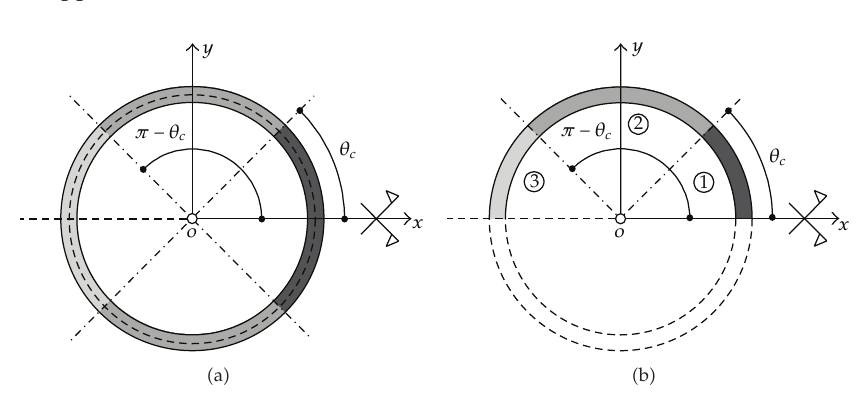
Figure 4: Nonhomogeneous material